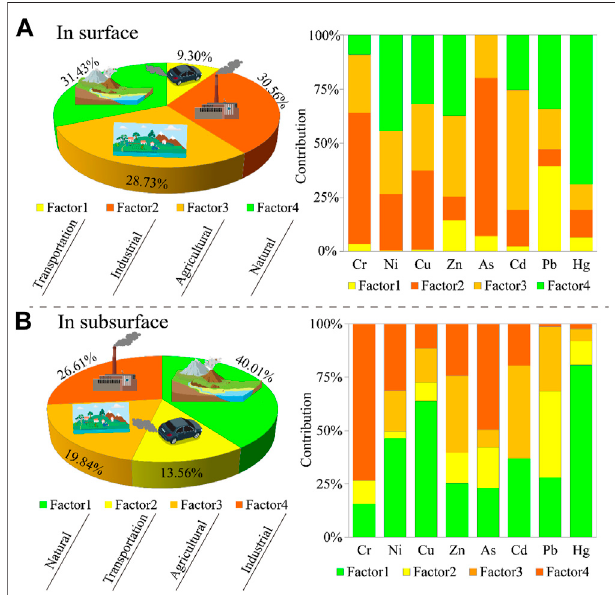
FIGURE 4 | Source apportionment of heavy metals in surface (A) and subsurface (B) soils.